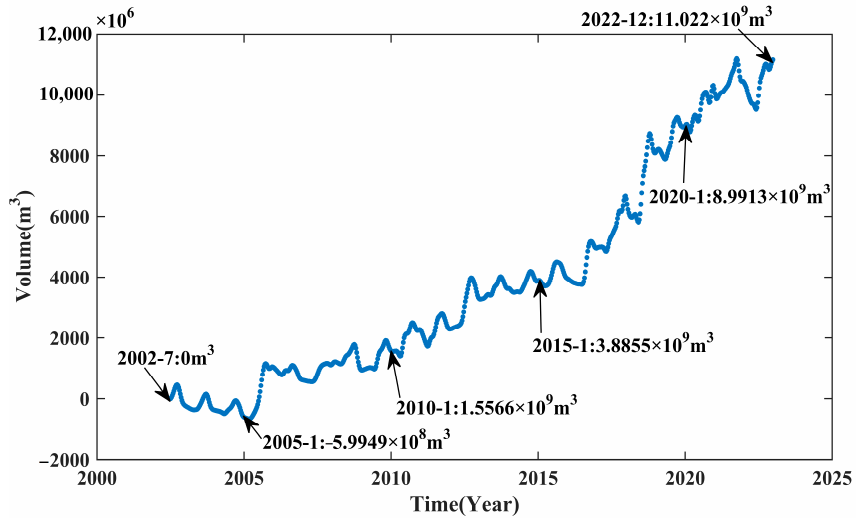
Figure 16. Time series of water storage growth in LQ.